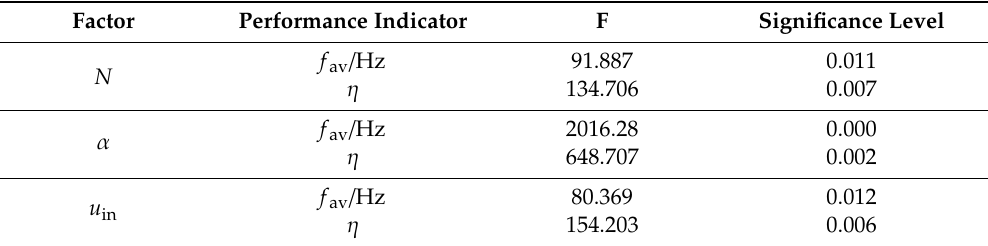
Table 4. Significance test of the tubular PBR with spiral ribs (double-sided illumination).